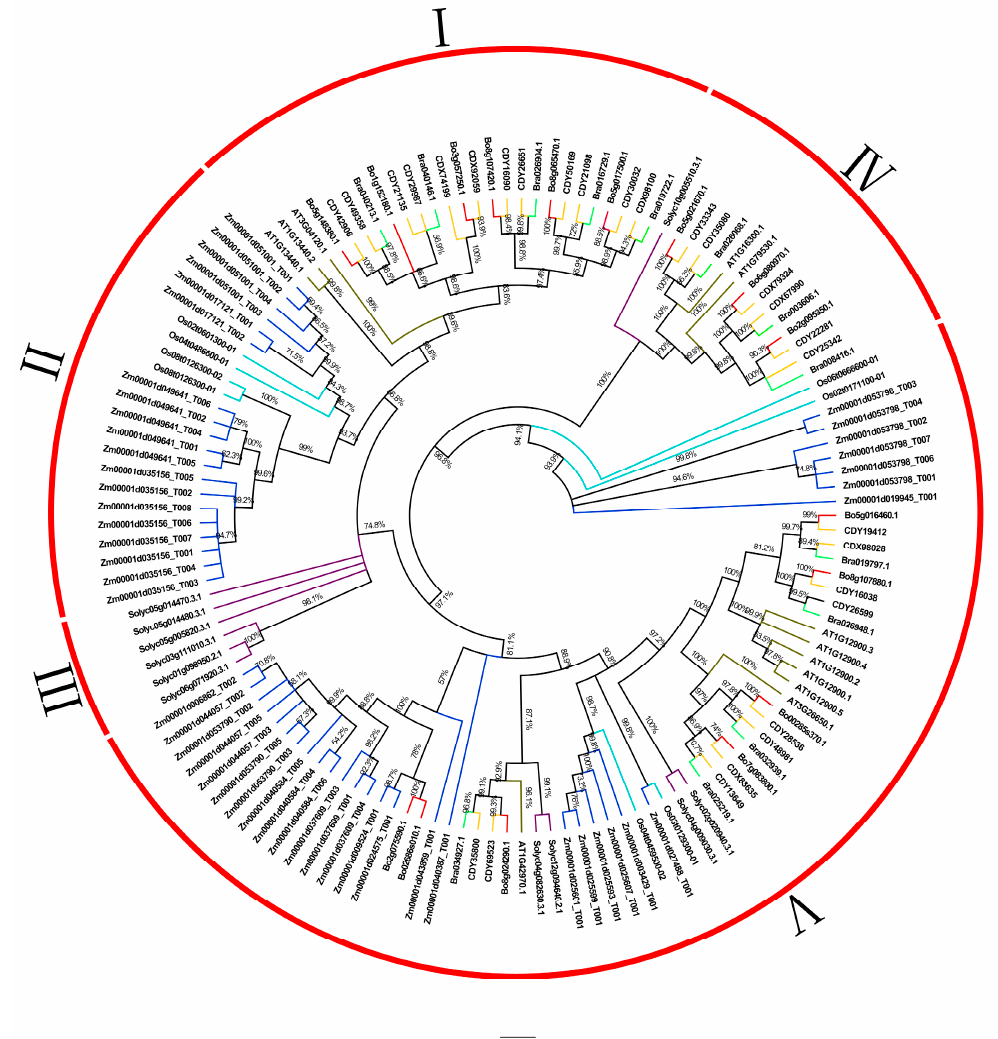
Figure 1. Phylogenetic analysis of GAPDH proteins in Brassica oleracea , Arabidopsis , turnip, Brassica napus , corn, rice and tomato species. The Maximum Likelihood (ML) phylogenetic tree was constructed by using MEGA X software; the bootstrap value is set to 1000. Group I is Cruciferae- specific, Group II is Gramineae- specific, Group III is Solanaceae- specific, Group IV consists of 14 Cruciferae and 1 Solanaceae GAPDH genes, and the rest, coded as Group V, are Cruciferae , Gramineae and Solanaceae . The red line indicates kale, the dark green line indicates Arabidopsis , the light green line indicates turnip, the dark blue line indicates maize, the light blue line indicates rice, the yellow line indicates kale-type oilseed rape and purple indicates tomato.